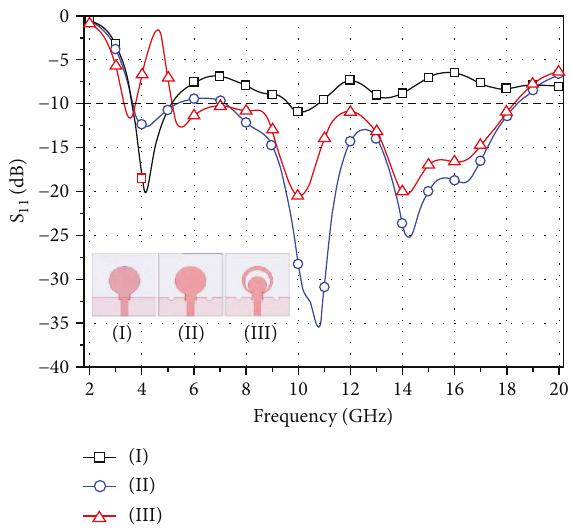
Figure 2: Evolution of single element of UWB-MIMO antenna and its S 11